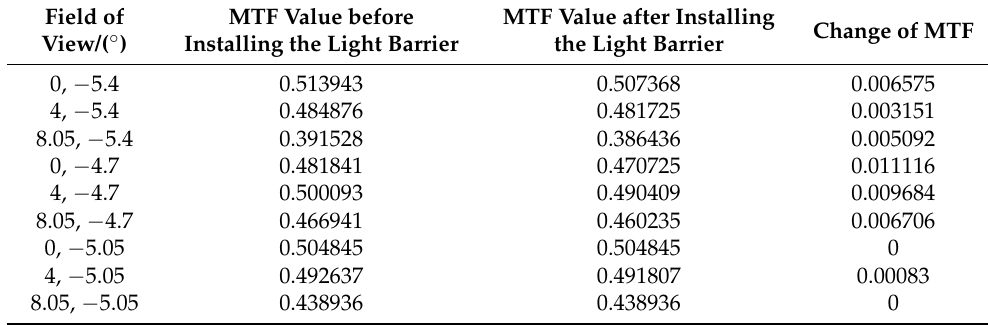
Table 9. Statistical table of MTF changes in different fields of view in the tangential